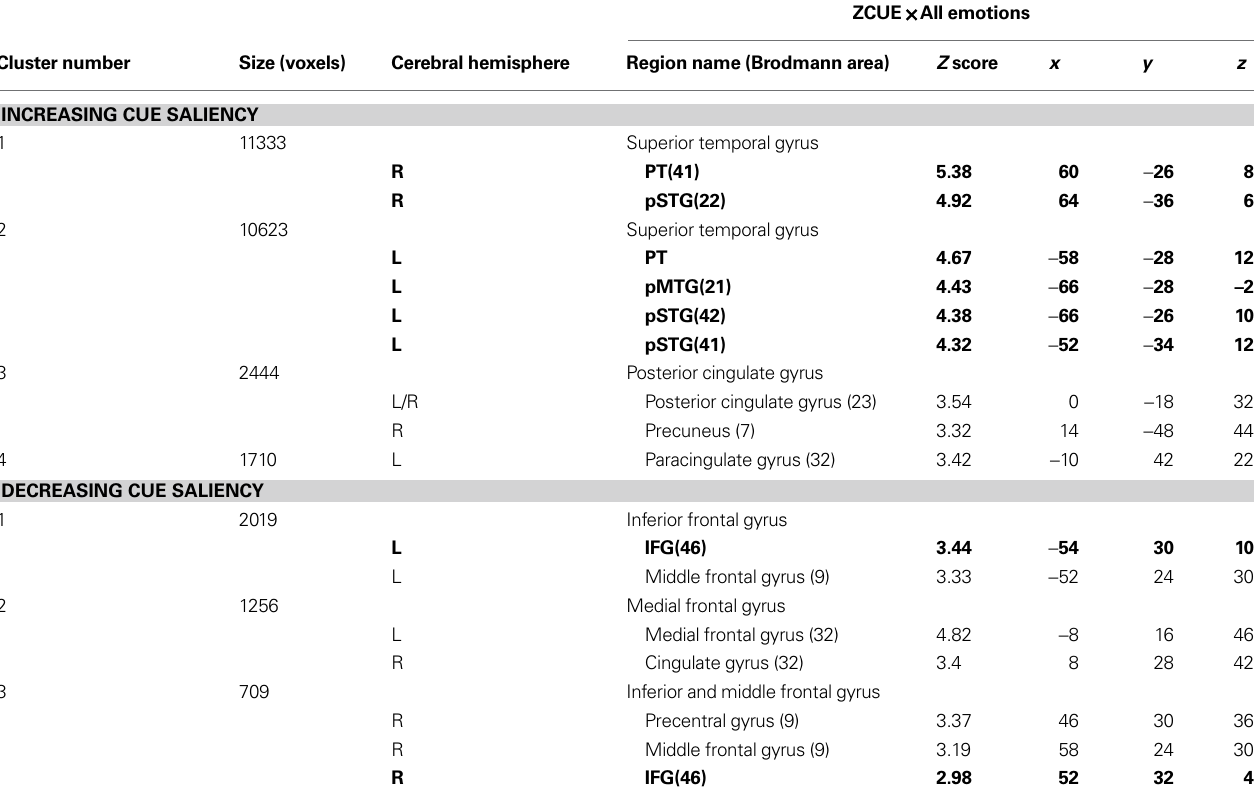
Table 3 | Mean cluster location and local maxima of BOLD signal change for all emotions × cue saliency